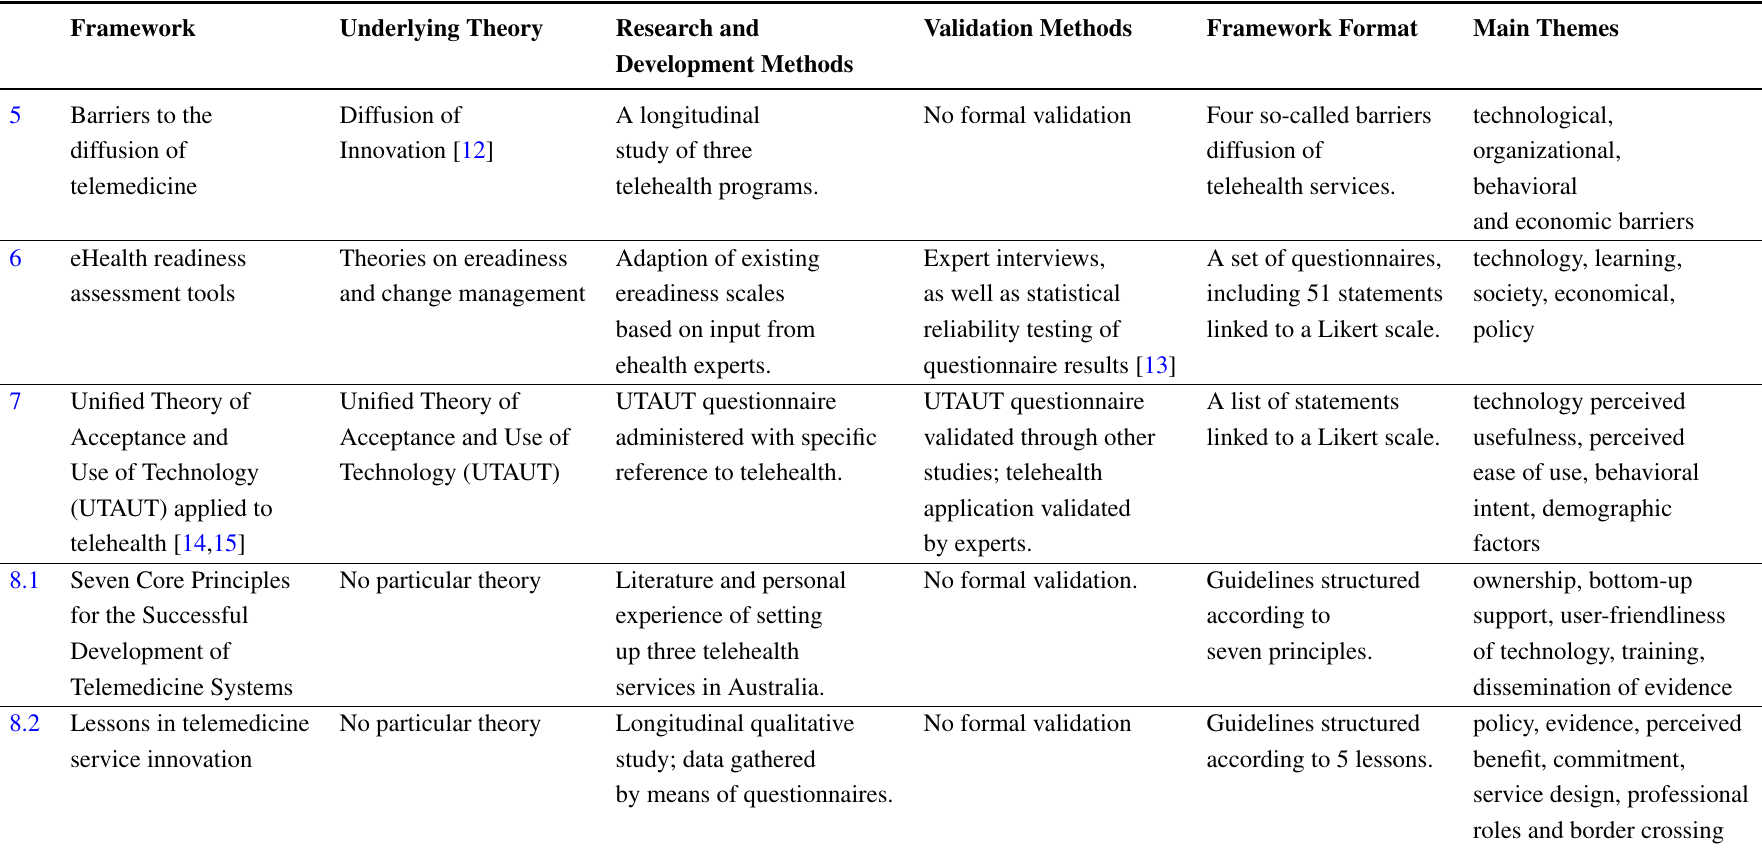
Table 2. Comparison of